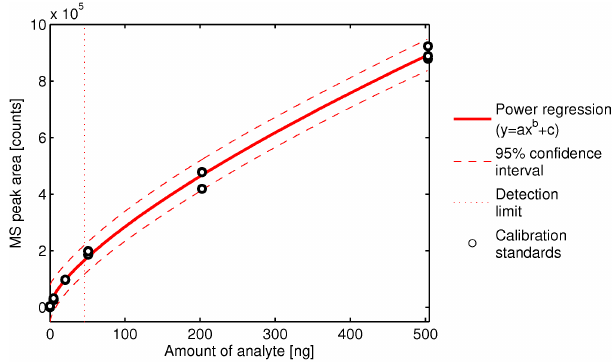
Figure 2. Example of IC/MS calibration (methylmaleic